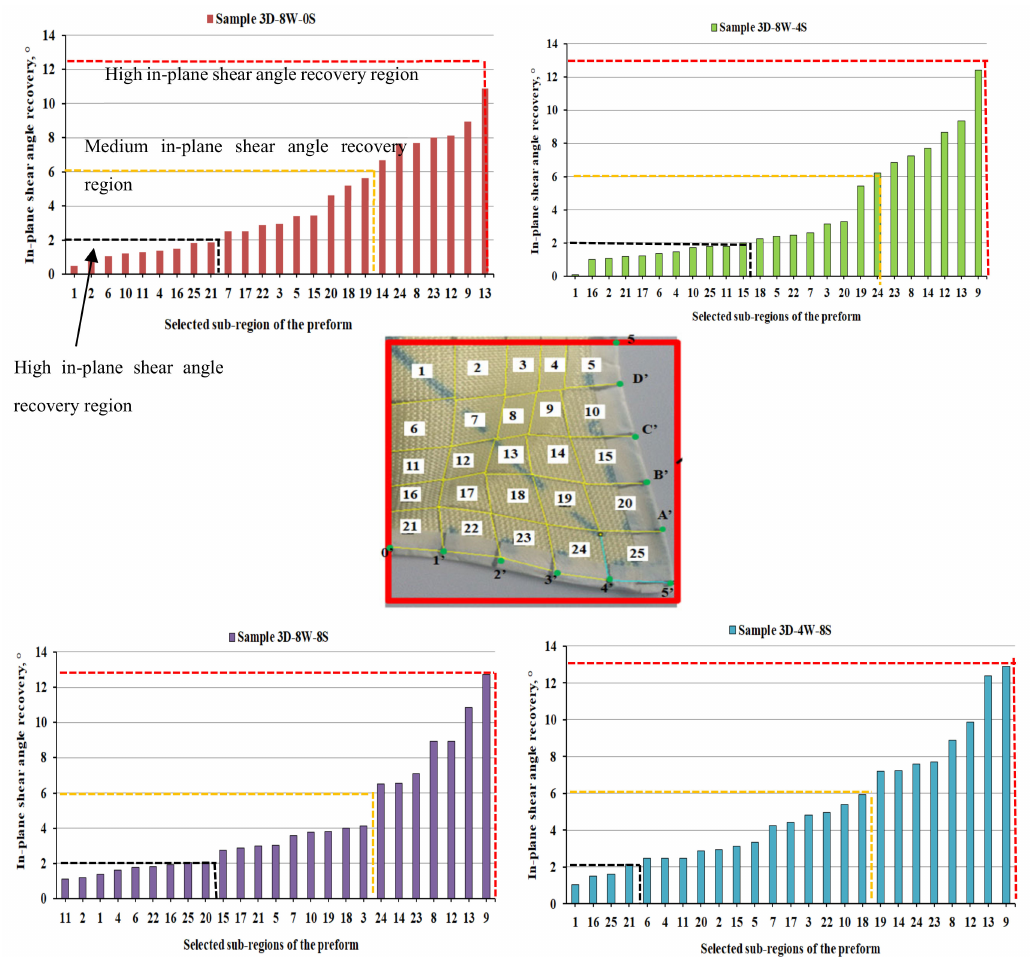
Figure 19. In-plane shear angle recoveries for the selected sub-regions of the di ff erent 3D warp interlock preforms in ascending